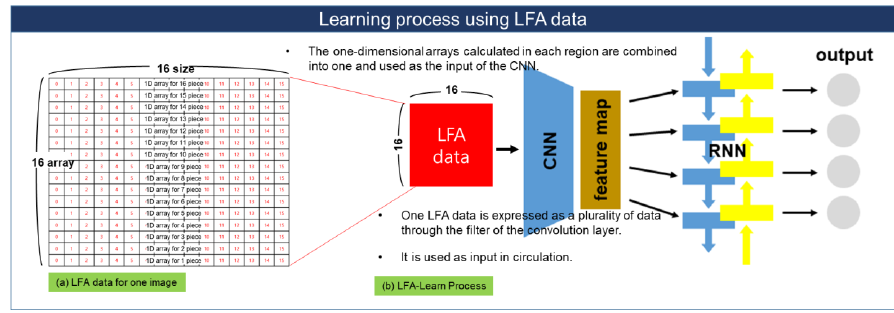
Figure 7. Learning process using LFA data: ( a ) LFA data for one image; ( b ) LFA-Learn